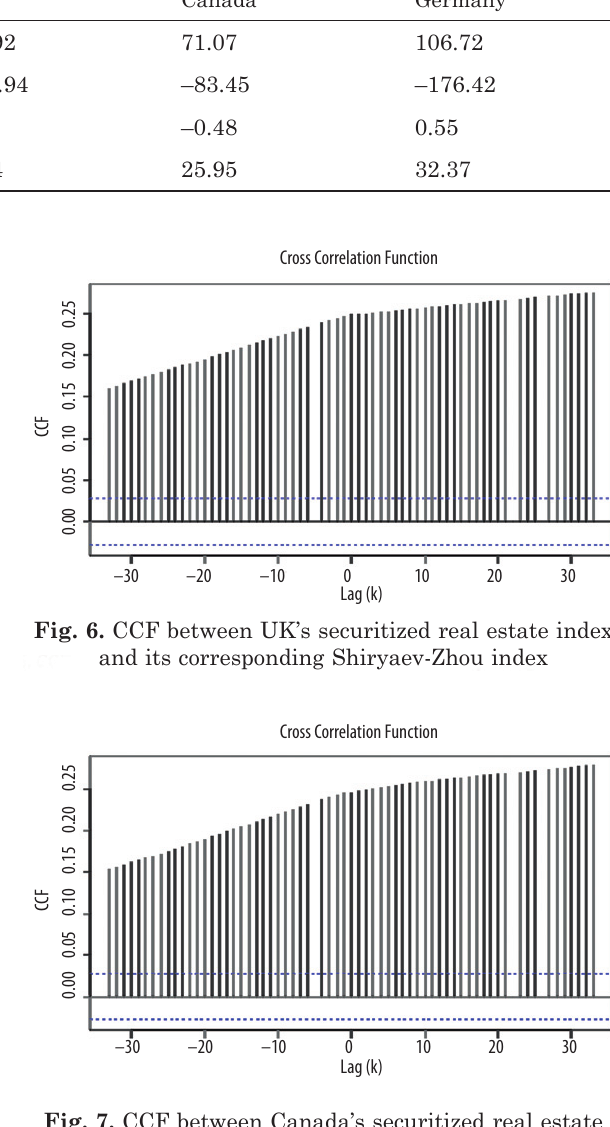
Fig. 5. CCF between US’s securitized real estate index and its corresponding Shiryaev-Zhou index